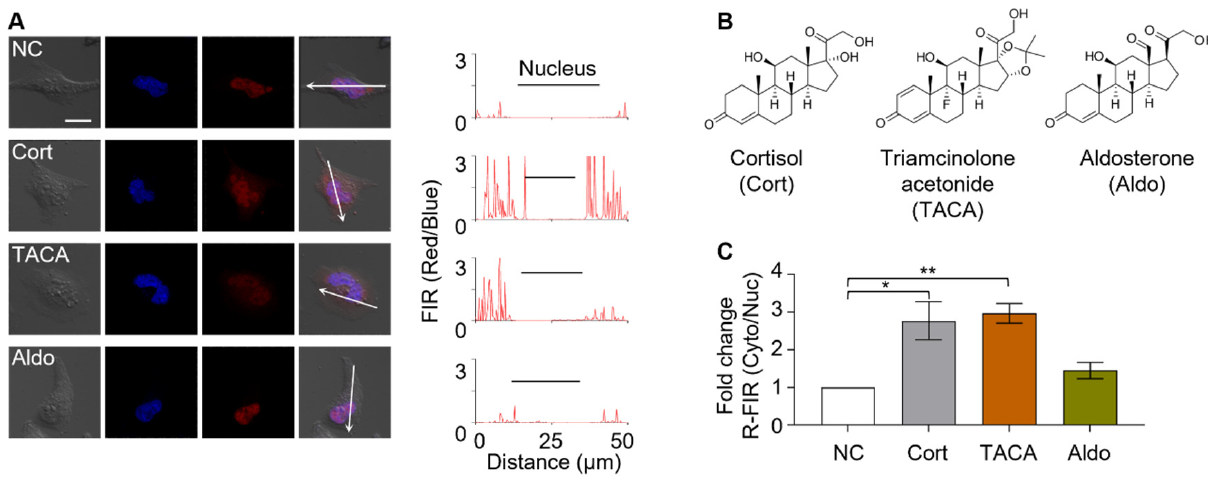
Figure 3. Evaluation of Cort-detecting sensor cells for function-based screening. ( A ) The sensor cells responded to Cort and the GR agonist, triamcinolone acetonide (TACA), while discriminating against the structural analogues, aldosterone (Aldo) (scale bar = 20 µm). ( B ) The structures of Cort, TACA, and Aldo. ( C ) Fold change in the ratio of red fluorescence intensity from the cytoplasm to that of the nucleus (R-FIR Cyto/Nuc) over untreated control sensor cells is calculated. Data were analyzed by one-way ANOVA using the Tukey multiple comparison test (* p < 0.05, ** p < 0.01).